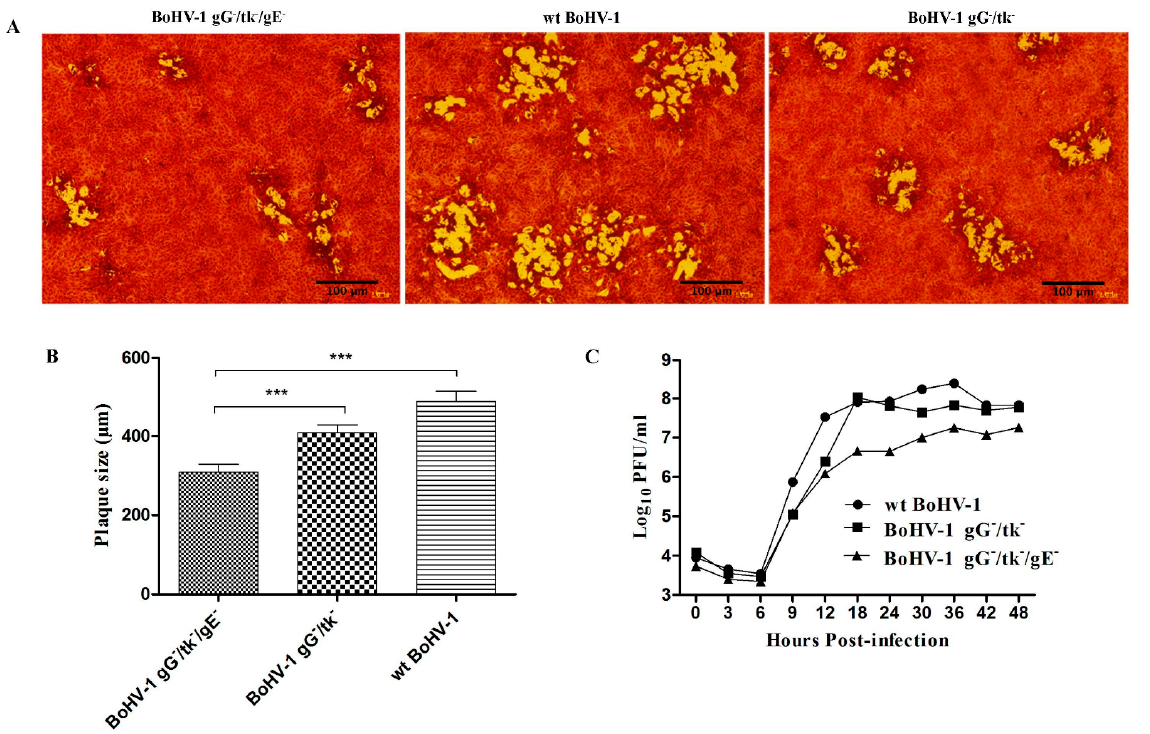
Figure 2. Growth characteristics of BoHV-1 gG-/tk-/gE- compared with wt virus and BoHV-1 gG-/tk- in vitro. ( A ) Plaque morphology of BoHV-1 gG-/tk-/gE-, BoHV-1 gG-/tk-, and wt BoHV-1 in MDBK cell monolayers. ( B ) The diameter of 30 plaques for each virus. ( C ) One-step growth curve of BoHV-1 gG-/tk-/gE- and wt BoHV-1 viruses in MDBK cells. The mark (***) with p < 0.001 refers to highly significant.